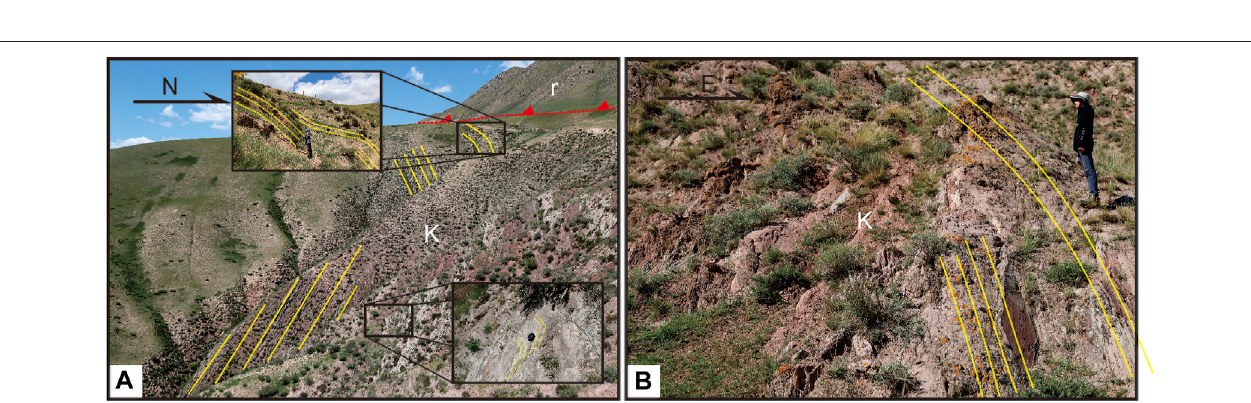
FIGURE 7 | Field photos of the GZT fault and related deformation. Yellow lines mean bedding. ( Figure 5 for regional location of this map). (A) Fault plane in the southernGaizhangdabanarea,whereCretaceousstrataaredeformednearthefaultplane.Thelowerstratadip~50 ° southward,butbecomeverticalinthemiddlestrata. Theupperstratadipnorthward~60 ° .Thedeformationexhibitsasouthwardtectonicpolarity,therebyindicatingthatdeformationwasrelatedtosouthwardthrustmotion. (B) Folds topping to the central basin in the Shagousi area. Near the GZT, the Cretaceous strata dip vertically, while the upper strata are reversed. This fold also exhibits tectonic polarity toward the basin. K: Cretaceous strata. N: Neogene strata.